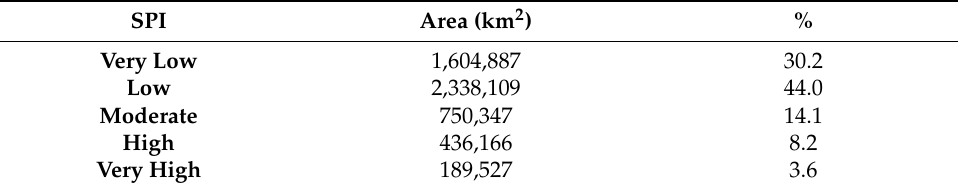
Table 12. Regional-scale of soil productivity for the studied countries.